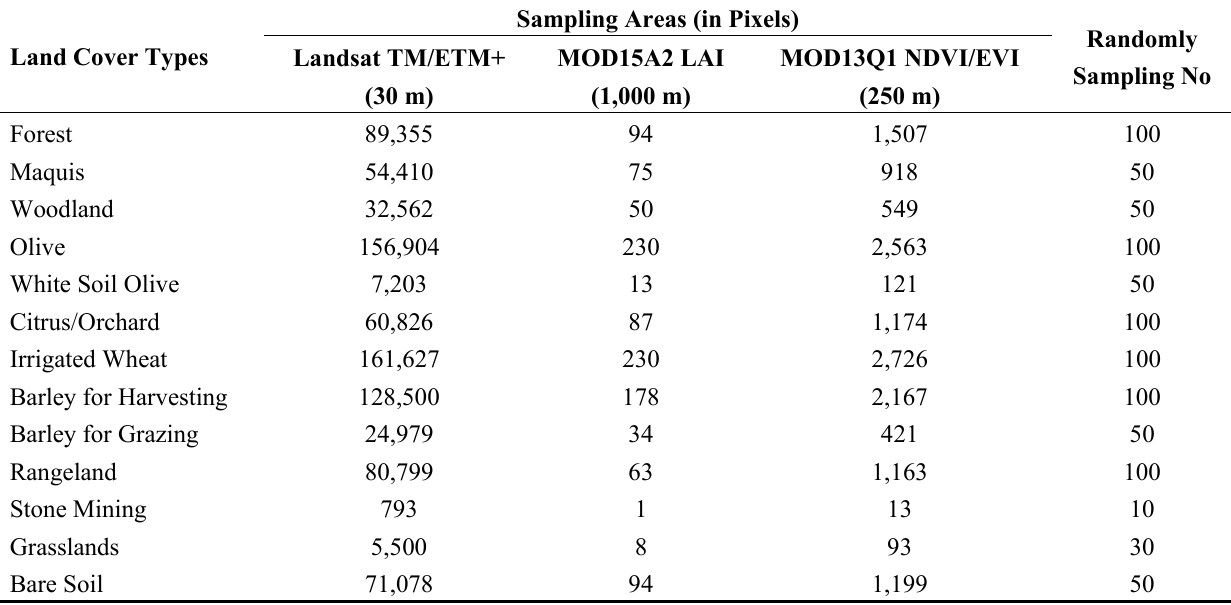
Table 4. Sampling areas before pixel resizing and random sample number in each land cover type taking the Landsat-MODIS pair of 1 May 2007 as an